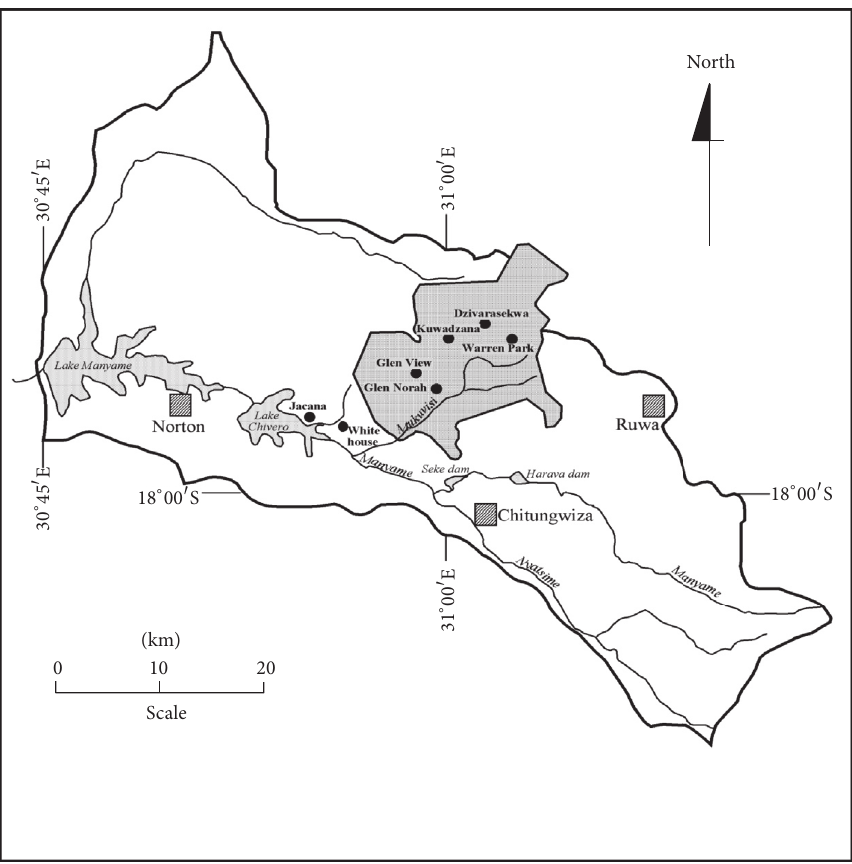
Figure 1: A schematic representation of the catchment area of Lake Manyame and Lake